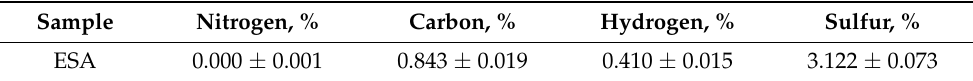
Table 3. Elemental analysis of the chemical elements nitrogen, carbon, hydrogen, and sulfur in the sample from the San Andr é s waste dump